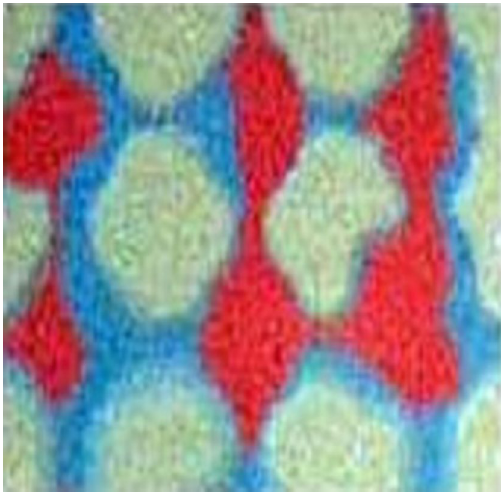
Fig. 4 A magnified view of the etched glass (blue and red colors refer to water and oil phases,